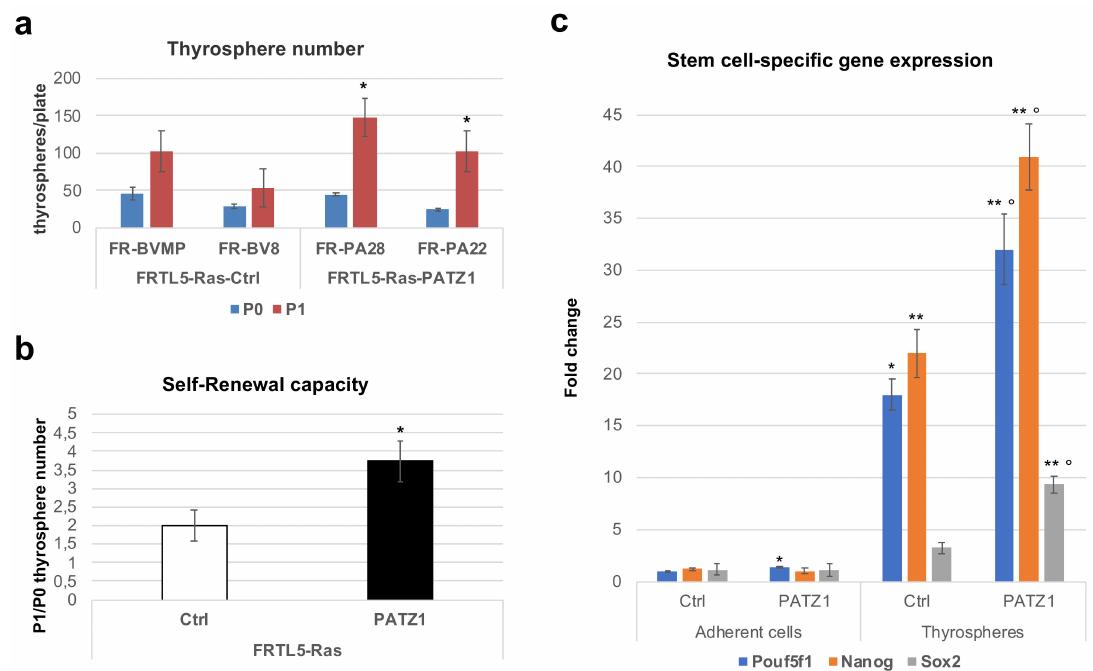
Figure 3. Stemness potential of Ras transformed rat thyroid cells. ( a ) Thyrosphere number was counted in two serial passages every 14 days. P0 = primary thyrospheres; P1 = secondary thyrospheres. Two clones for both FRTL5-Ras-Ctrl (FR-BVMP, FR-BV8) and FRTL5-Ras-PATZ1 (FR-PA28, FR-PA22) cells [19] were analyzed. Mean values ± SE of three independent experiments are reported. *, P < 0.05, versus P0 thyrospheres, as assessed by t-test. ( b ) Self-renewal capacity was evaluated by the P0/P1 ratio of thyrospheres number. *, P < 0.05; ( c ) qRT-PCR analysis of Pouf5f 1, Nanog and Sox2 gene